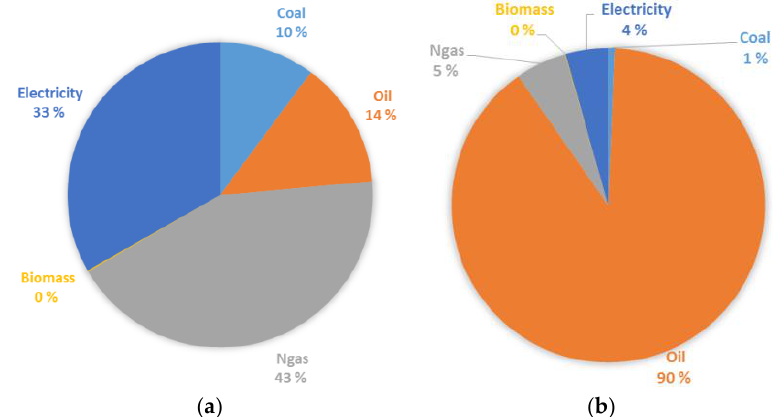
Figure 4. Fuel consumption for ( a ) industry and ( b ) various energy uses in Italy.